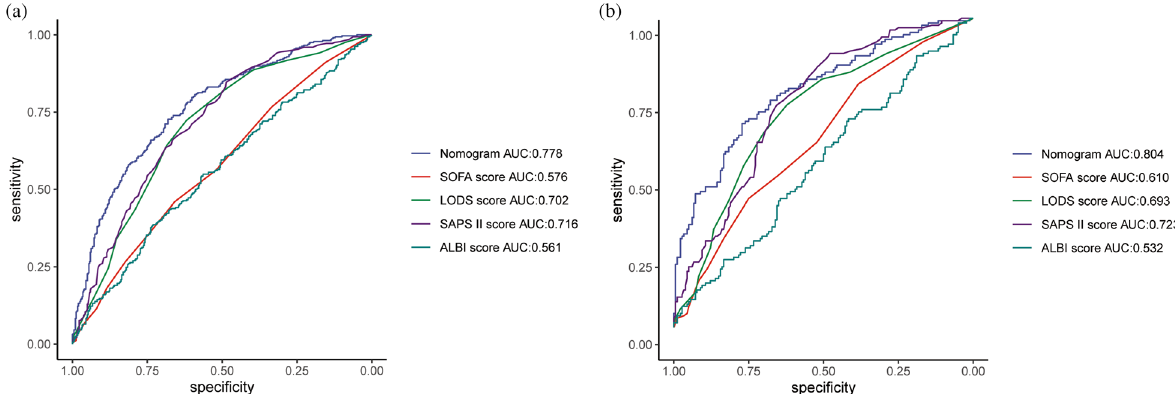
Figure 4. The ROC curve of the nomogram. ( a ) Training set; ( b ) validation